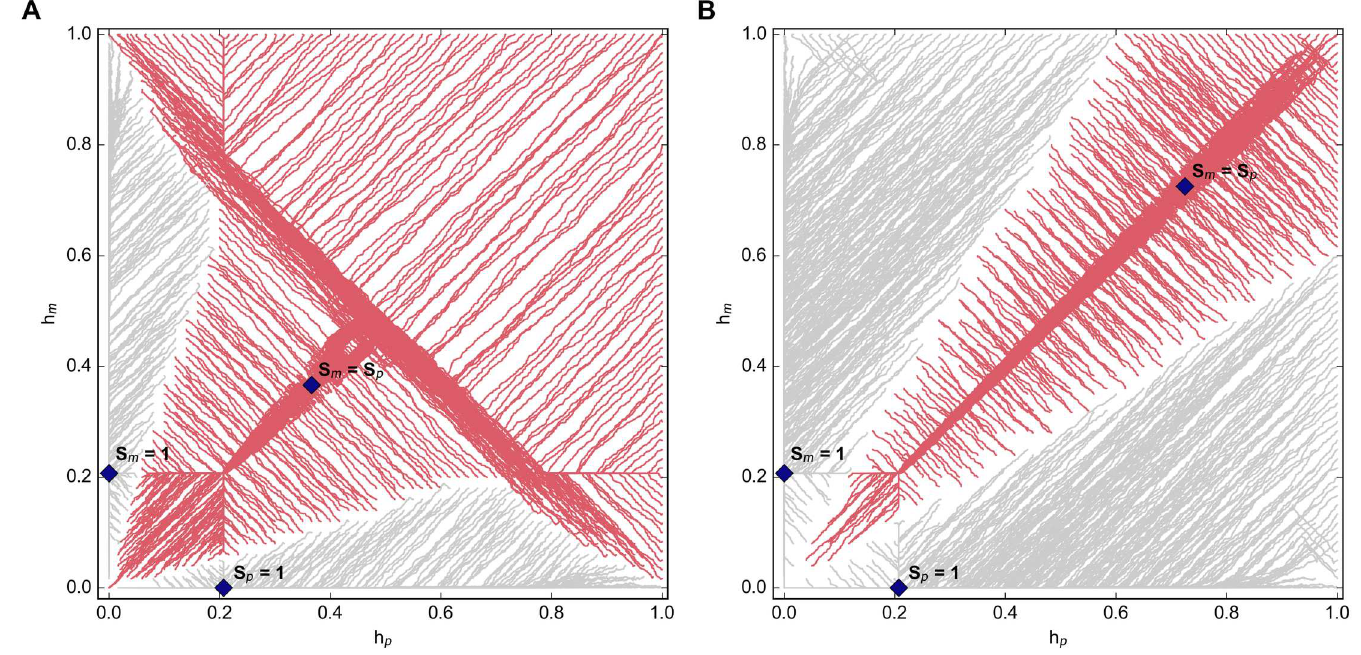
Fig 4. Equilibrium help trajectories with evolving proportions. (a) z = 2; (b) z = 5 for evolvingproportions of S m and S p .